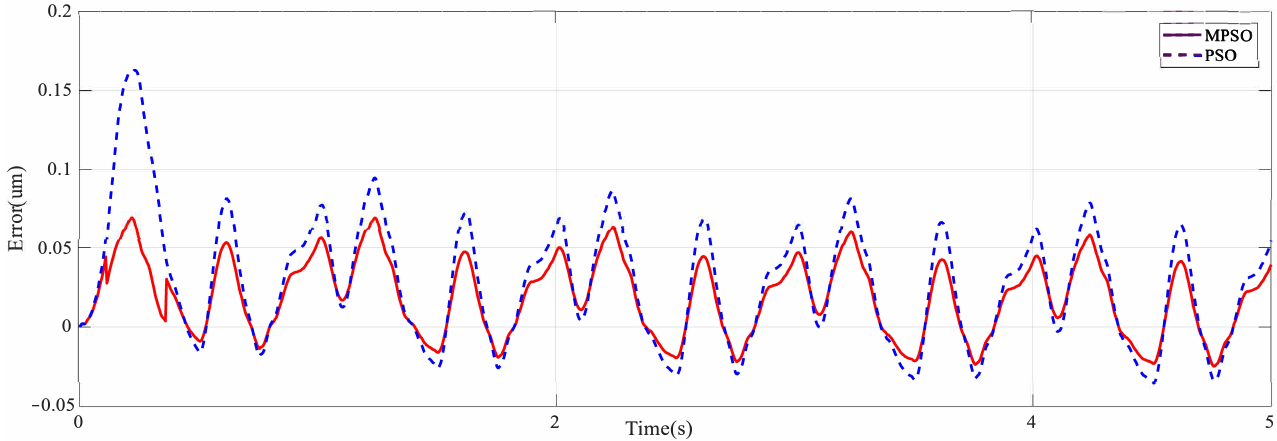
Figure 8. Output displacement error of PSO and